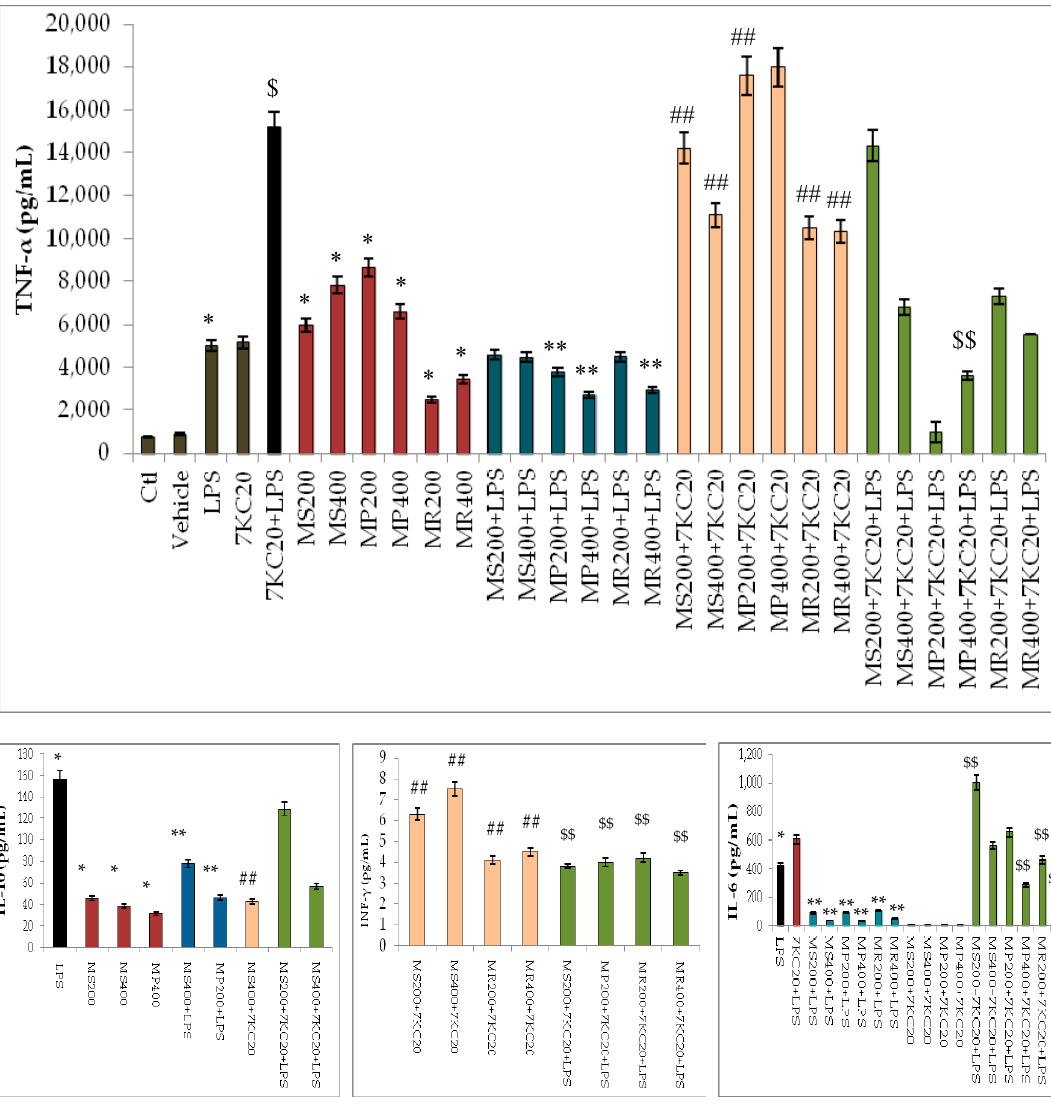
Figure 2. Effect of mint extracts on cytokine secretion. Data shown are mean ± SD from three independent experiments. They were analyzed by the ANOVA’s test followed by a t test. A p -value of 0.05 or less was considered as statistically significant ( p < 0.05). No significant differences were observed between control (Ctl; untreated cells) and vehicle (ethanol 0.1%). *: comparison lipopolysaccharide (LPS), Mentha spicata (MS), Mentha pulegium (MP) and Mentha rotundifolia (MR) LPS, MS, MP and MR extracts versus Ctl; #: comparison 7KC20 versus vehicle; $: comparison (7KC20 + LPS) versus vehicle; **: comparison (MS, MP or MR extracts + LPS) versus LPS; ##: comparison (MS, MP or MR extracts + 7KC20) versus 7KC20; $$: comparison (MS, MP or MR extracts + 7KC20 + LPS) versus (7KC20 + LPS). Cytokine values lower than the limit of detection (IL-6: 5 pg/mL; IL-10: 17.5 pg/mL; MCP-1: 52.7 pg/mL; IFN- γ : 2.5 pg/mL; TNF α : 7.3 pg/mL) were considered as not detectable, and